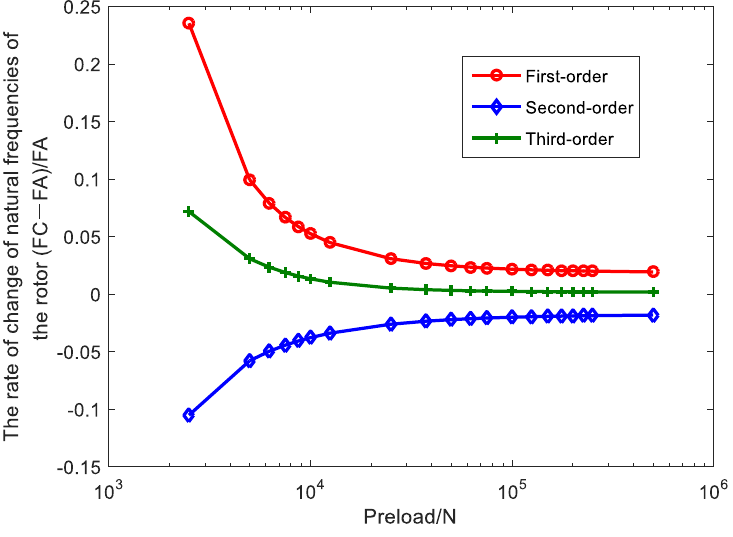
Figure 14. The rate of change of natural frequencies of the RFR considering the coordinate deformation of tie